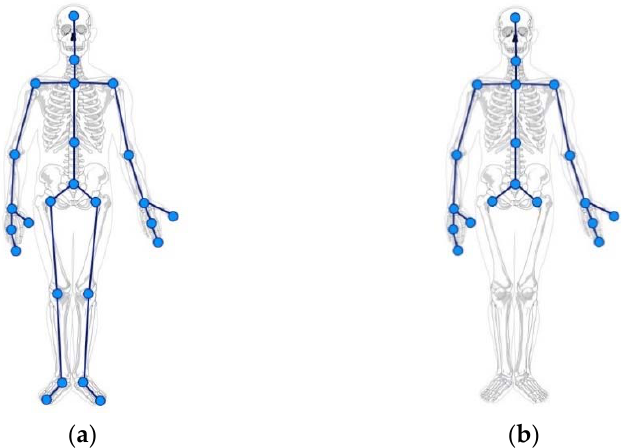
Figure 2. ( a ) 25 body components of the skeleton model; ( b ) 19 upper body components of the skeleton model for seated users.